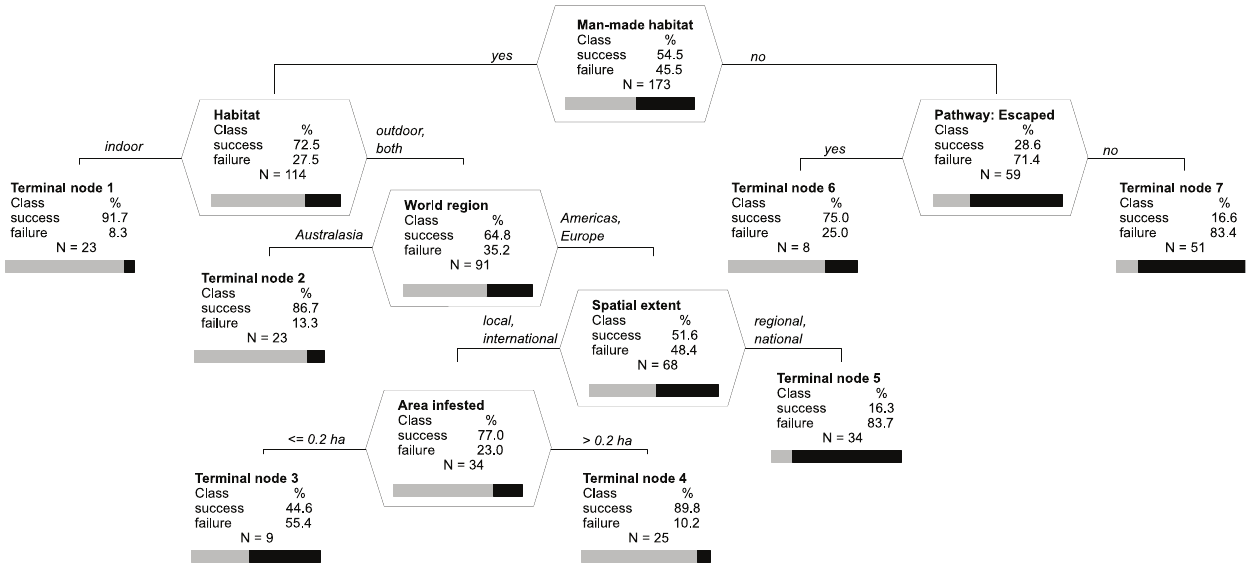
Figure 1. Optimal classification tree for factors relating to success and failure of 173 eradication campaigns against invertebrate plant pests, plant pathogens (viruses/viroids, bacteria and fungi) and weeds in a model without any predetermined structure. Splitting nodes (polygonal tables with splitting variable name) and terminal nodes (with a split criterion above each) show a table with columns for the outcome (success/failure) and % of weighted cases for each outcome, total number of unweighted cases (N), and graphical representation of the percentage of success (grey) and failure (black) weighted cases (horizontal bar). Vertical depth of each node is proportional to its improvement value that corresponds to explained variance at the node. Overall misclassification rate of the optimal tree is 15.8% compared to 50% for the null model, with 16.7% misclassified success and 14.8% failure cases. Sensitivity (true positive rate, defined as the ability of the model to predict that a case is eradicated when it actually is) is 83.3 and specificity (true negative rate, defined as the ability of the model to predict that a case is not eradicated when it is not) 85.2% for learning samples, i.e. the samples not used to build the models for assessment of cross-validation errors, and 77.1 and 69.0%, respectively, for cross-validated samples, i.e. the best estimates that would occur if the models were to be applied to new data, assuming that the new data were drawn from the same distribution as the learning data.